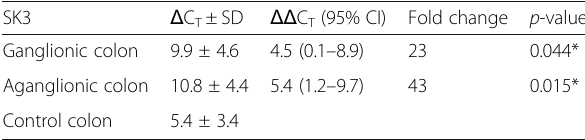
Table 2 The SK3 expression in both the ganglionic and aganglionic colon of HSCR patient and control